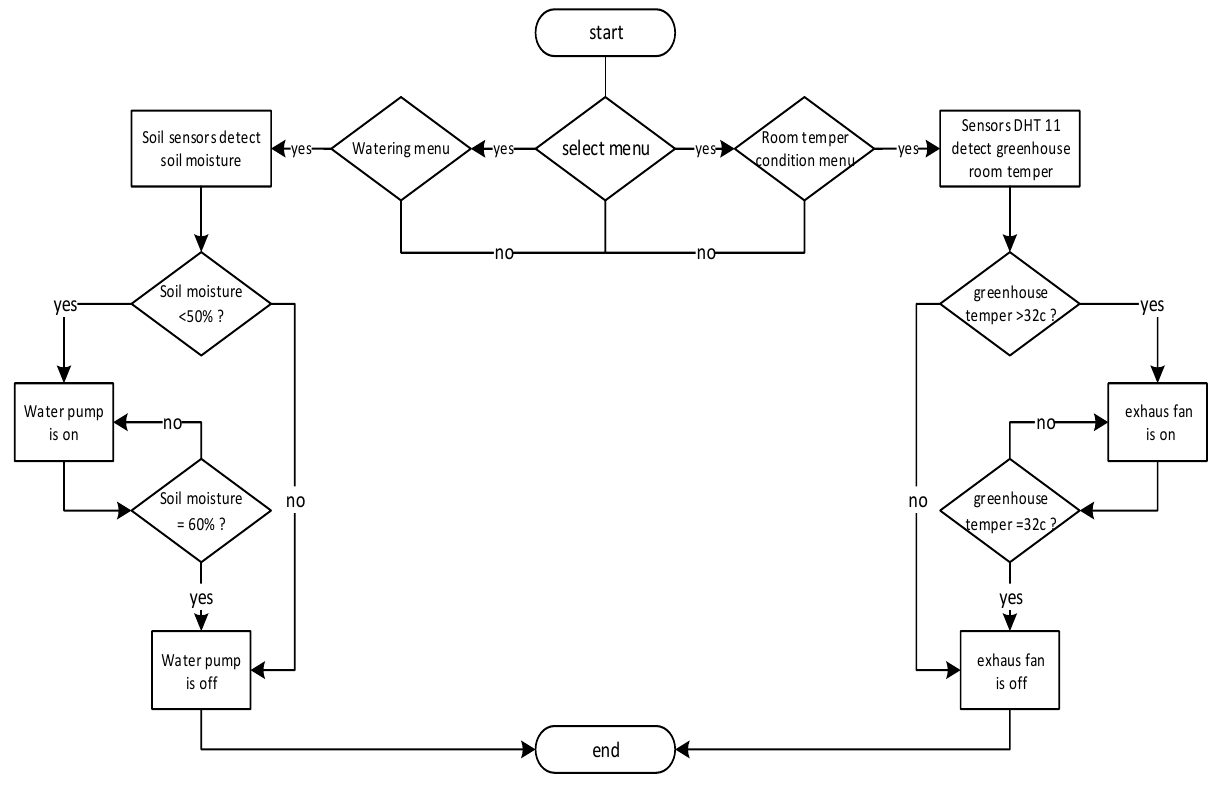
Figure 5. Flowchart of the proposed